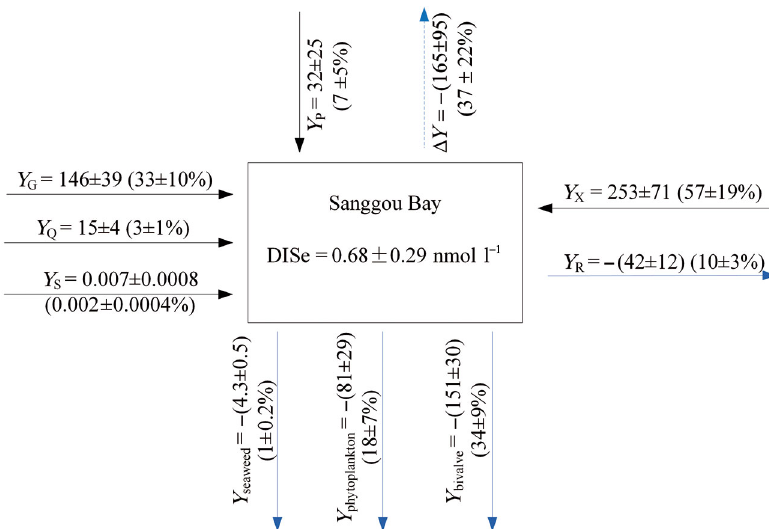
Fig. 6. Selenium budget in Sanggou Bay, showing inputs and outputs ( Y) as absolute values (kg yr −1 ; mean ± SD) and as percentages of total input. Positive values of Y indicate transport into Sanggou Bay; negative values indicate export of dissolved inorganic selenium (DISe) from Sanggou Bay or assimilation by biological organisms. Y P : atmospheric deposition; Y Q : riverine input; Y G : groundwater input; Y X : exchange between Sanggou Bay and Yellow Sea; Y R : net transport from Yellow Sea to Sanggou Bay; Y S : sediment/diffusion; Δ Y : net internal